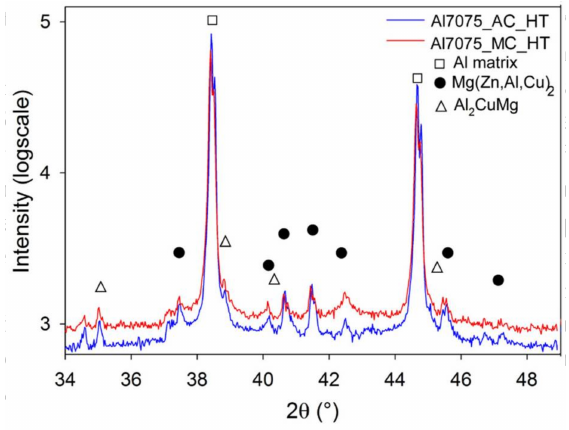
Figure 14. The XRD patterns of the annealed Al7075_AC_HT and Al7075_MC_HT compacts.